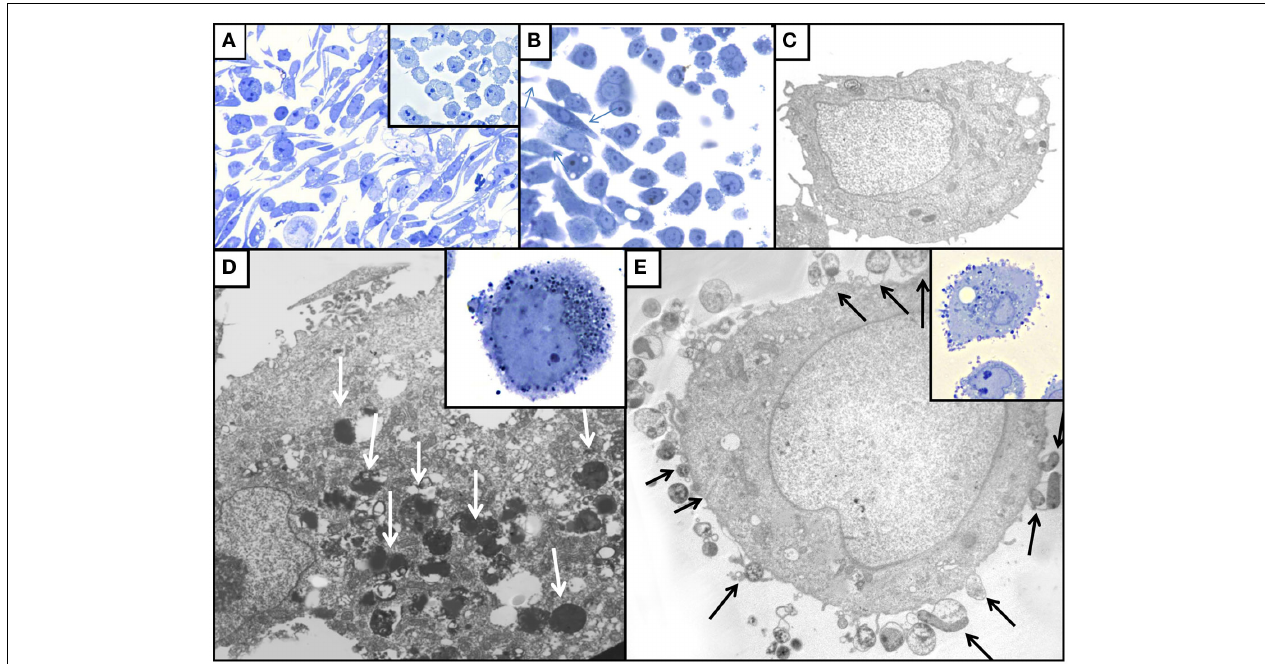
aspect. (D) TEM of AGS cell infected with J99WT H. pylori ; note intracellular H. pylori (white arrows). (E) TEM of AGS cell infected with Δ nudA allele; note H. pylori attached to AGS cell (arrows); insert shows the numerous Δ nudA H. pylori attached to AGS cell and relatively few intracellular bacteria. Original magnification of toluidine blue stained pictures (A) : 400 × ; (B) and insert of (A) : 1,000 × ; inserts of (D,E) : 1,000 × . Original magnification ofTEM pictures: (C) : 9,800 × ; (D) : 32,500 × ; (E) : 26,000 × .